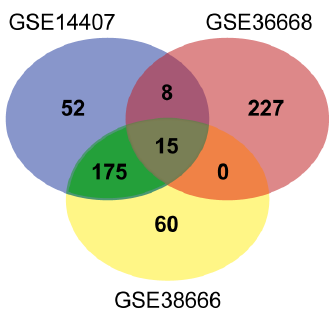
Figure 1. Venn diagram of DEGs among the GEO